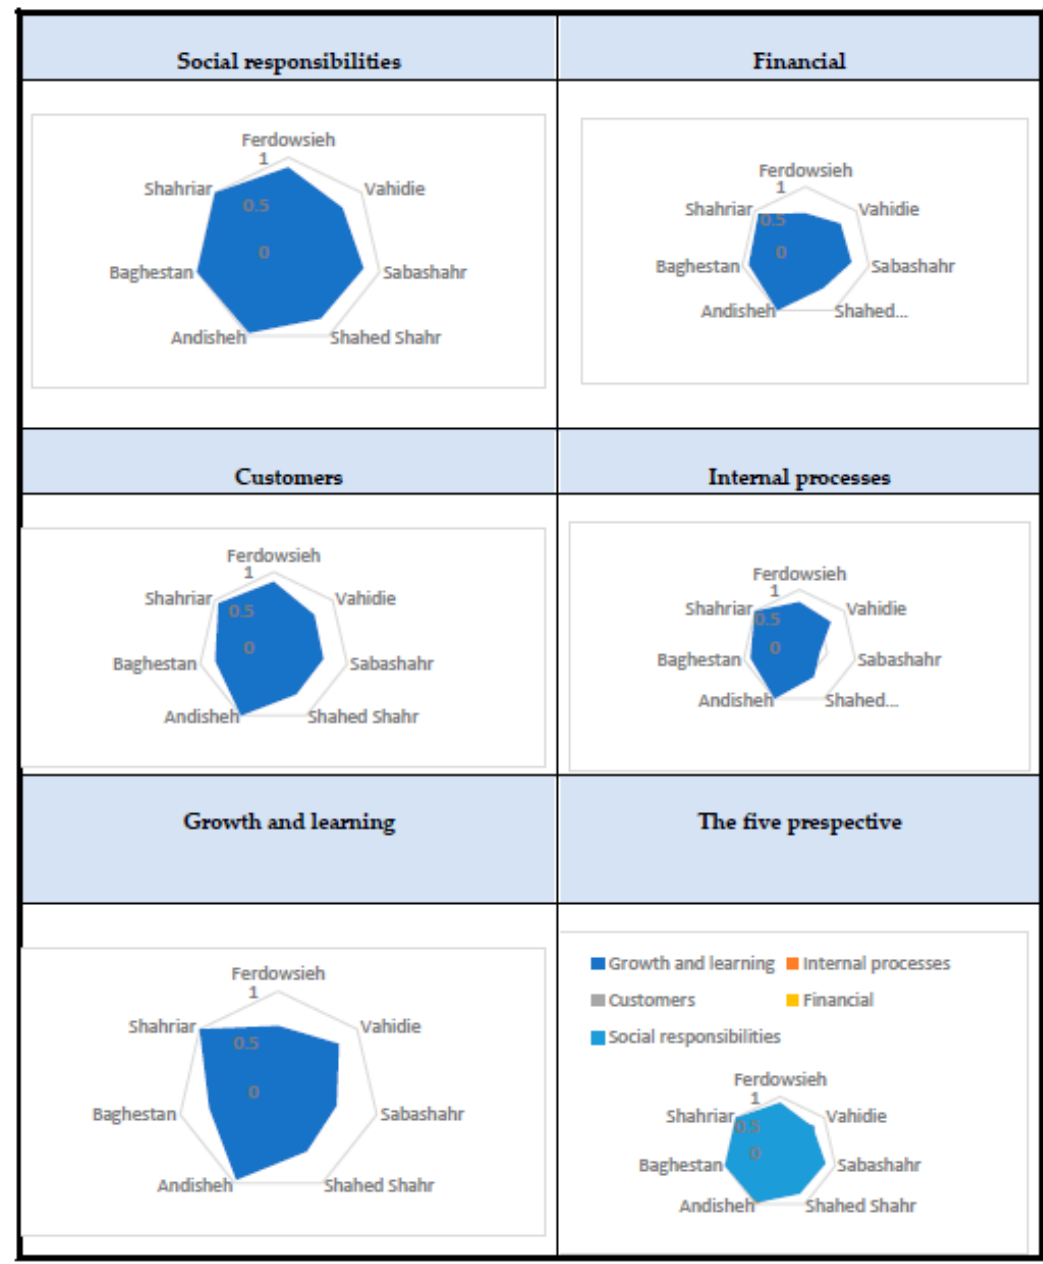
Figure 8. Diagram of various municipalities according to the balanced scorecard aspects. As shown, compared to the other municipalities, the municipalities of Andisheh and Shahriar have significantly better conditions in all five aspects. In terms of sustainable de- velopment issues, social responsibilities, with its financial aspect being important from the perspective of municipal managers, should be seen as one of the most crucial foundations of municipalities today. Superior performance was shown by the three municipalities of Andisheh, Baghestan, and Shahryar. This function has both positive and negative aspects. Considering the network structure of the model based on the interaction model between the five balanced scorecard domains depicted in Figure 2, this connection is established, as illustrated in Figure 9. The network model is sequential, and the customer and social responsibilities domains are grouped together in a single